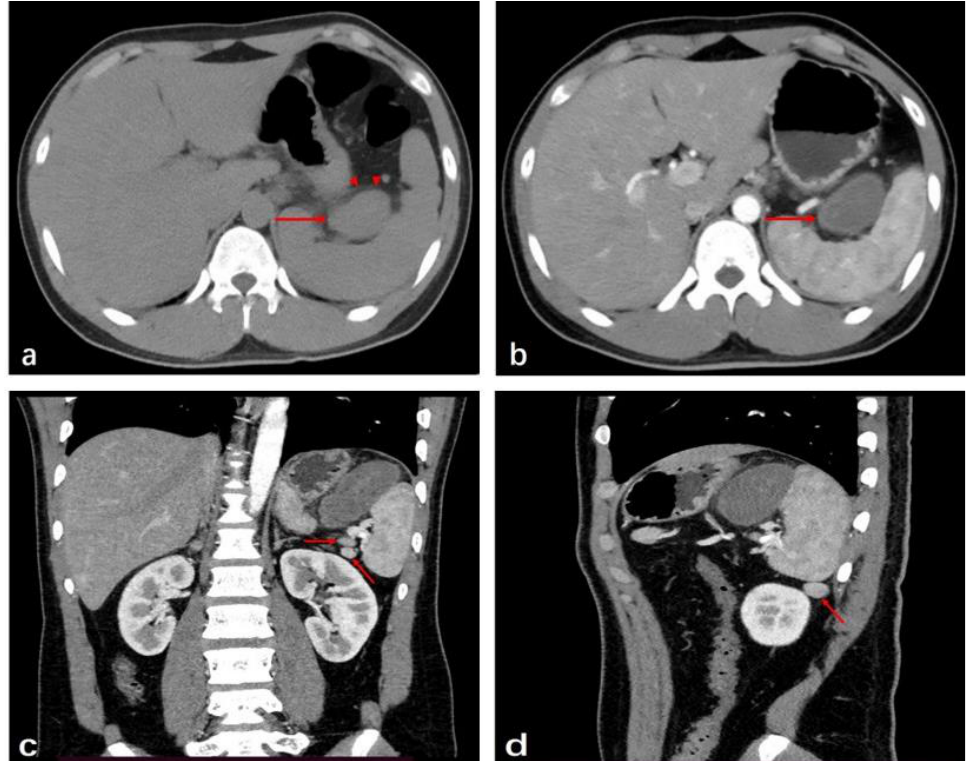
Figure 1. Computed tomography of the patient’s abdomen. ( a ): Non-contrast computed tomography revealed a mass-like soft-tissue density (red arrow) with adjacent inflammation (red arrowheads). ( b ): After enhancement, the mass was enhanced, and was circular (red arrow). ( c ): The CT enhancement showed two enhanced nodules at the hilum of the spleen (red arrow). ( d ): There was another enhanced nodule at the lower pole of the spleen (red arrow). The patient was admitted